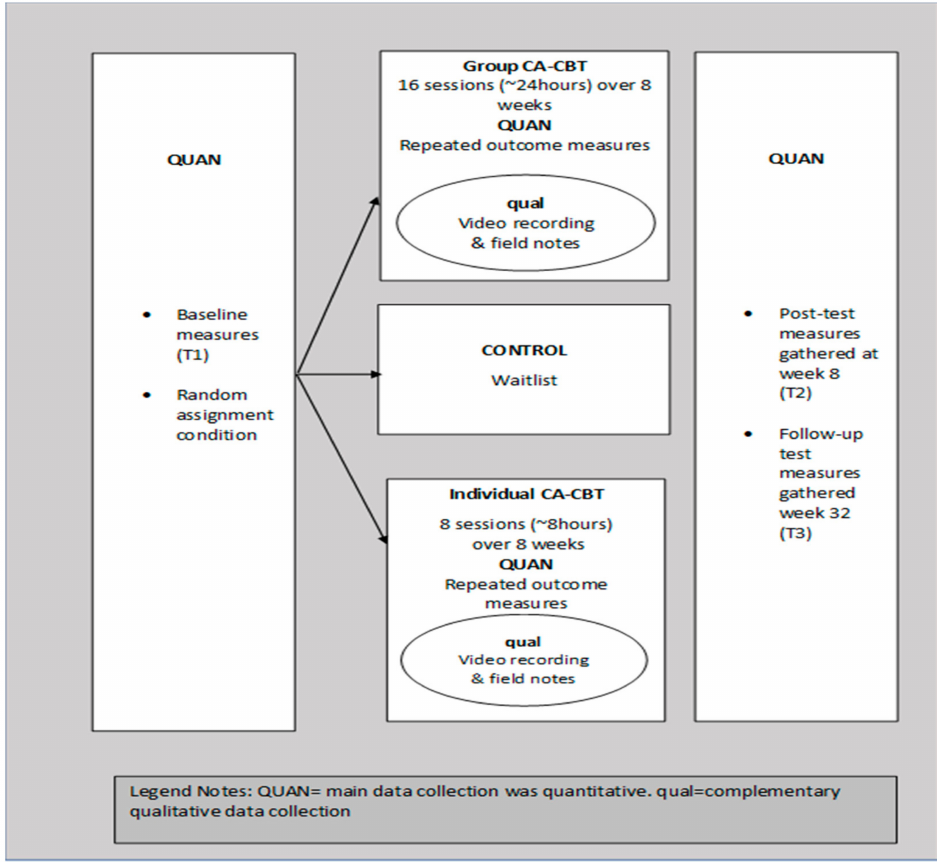
Figure 2. Research design of embedded randomized controlled